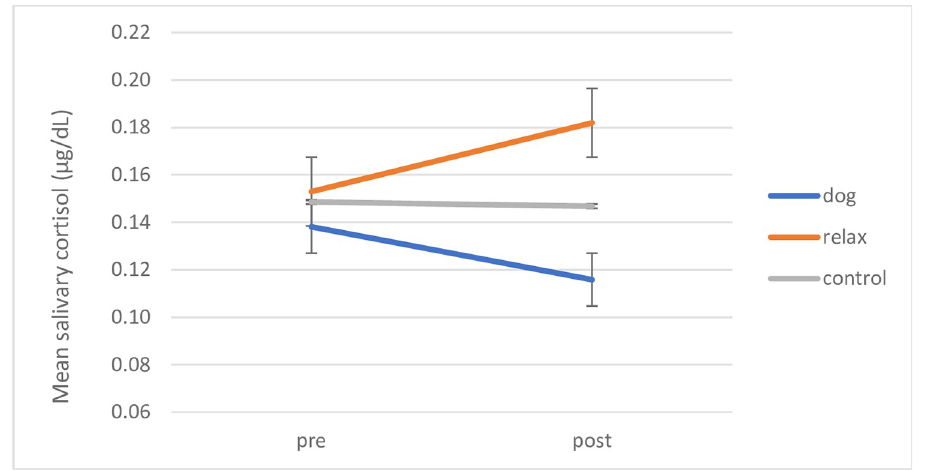
Fig 8. SEN cohort: Mean pre-post salivary cortisol by intervention condition. Mean pre-post salivary cortisol levels for SEN cohort shown by intervention condition. Error bars indicate standard error of mean.